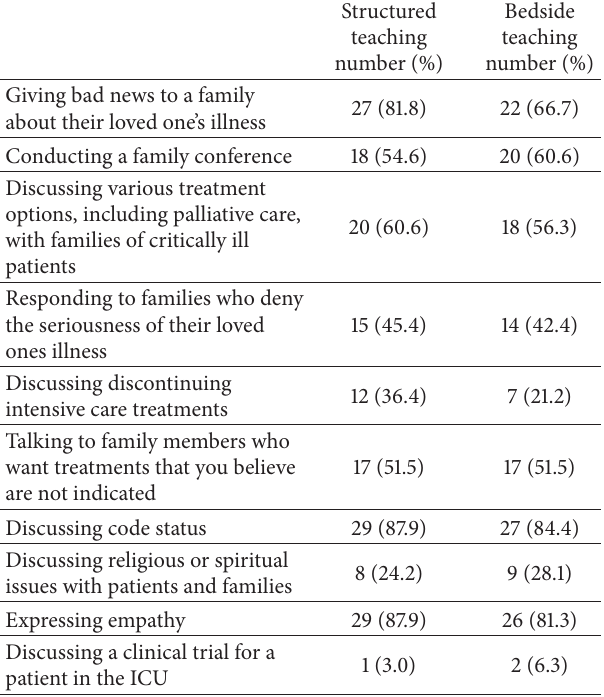
Table 2: Prior educational experiences.